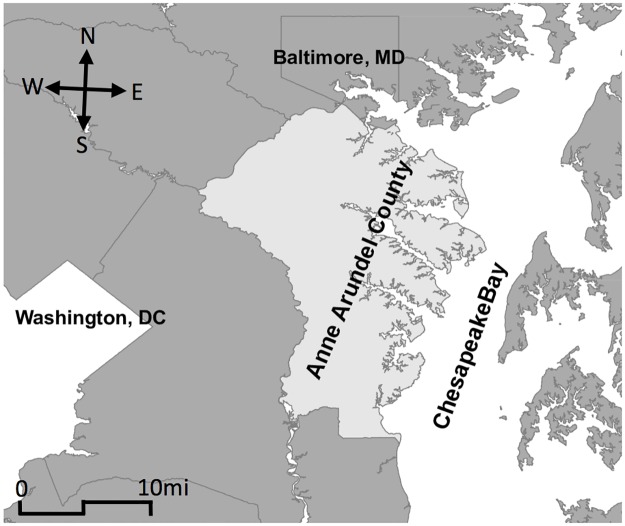
Map of region.[65].